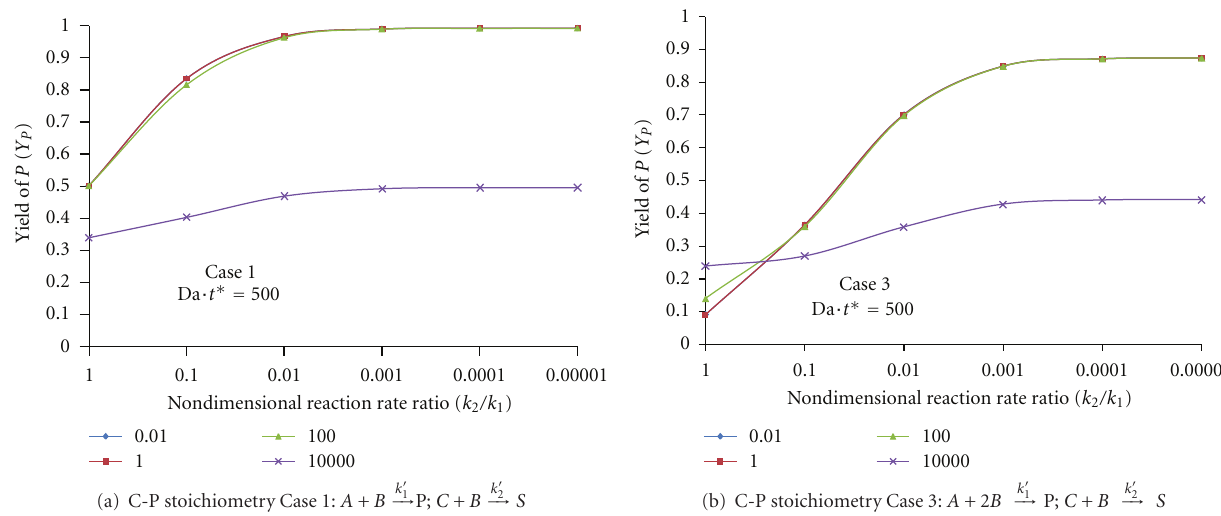
Figure 7: Plots of yield of P versus k 2 / k 1 for two sample C-P stoichiometries. The curves represent the di ff erent Da. Curves for Da = 0 . 01 lie exactly under the curves for Da = 1.